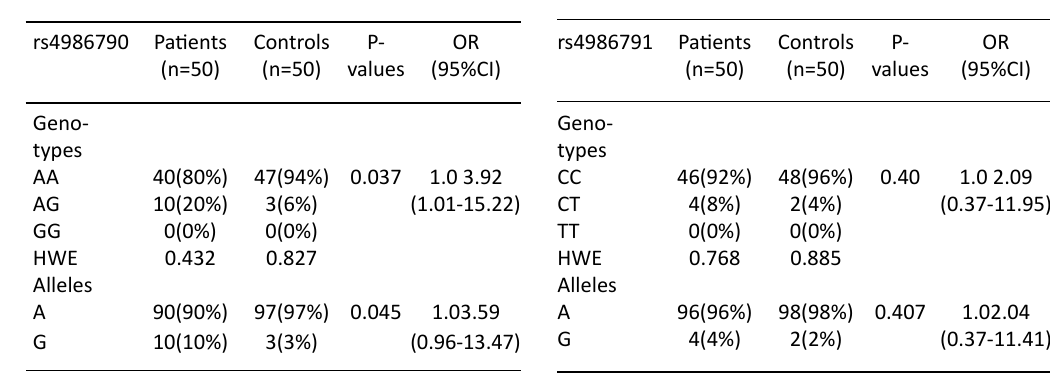
Table 4. Genotypes and alleles of TLR-4 rs4986791 in patients with seropositive IgM anti- toxoplasma Abs